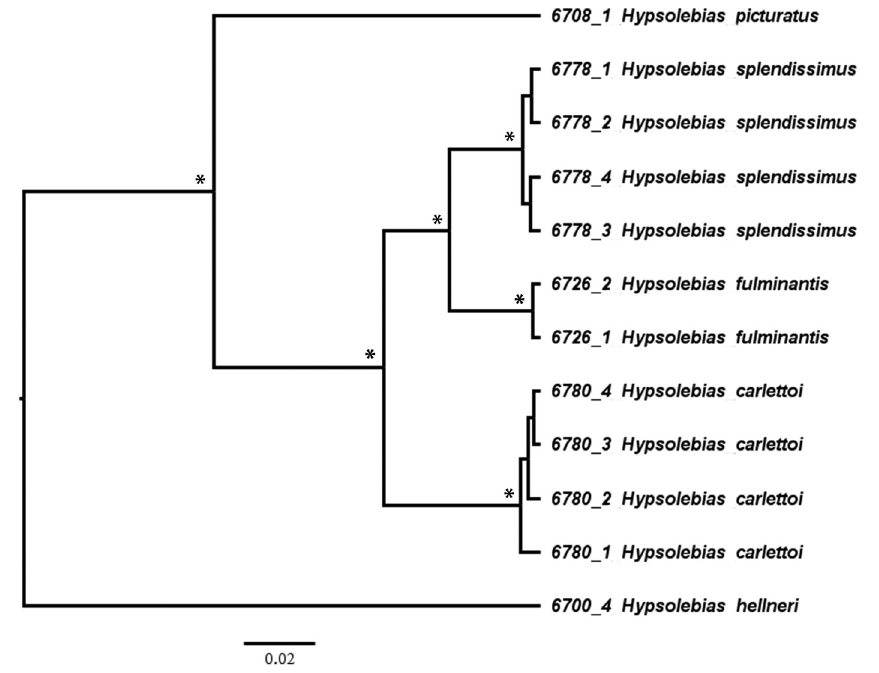
Figure 1. Bayesian phylogeny used to delimit species endemic to the upper Carnaíba de Dentro River drainage, inferred by using sequences of the mitochondrial gene cytochrome b, 416 bp. Posterior probability values below 95% are not depicted; asterisk above nodes represents maximum value of posterior probability (100 %); numbers before species names are catalogue numbers for voucher specimens.